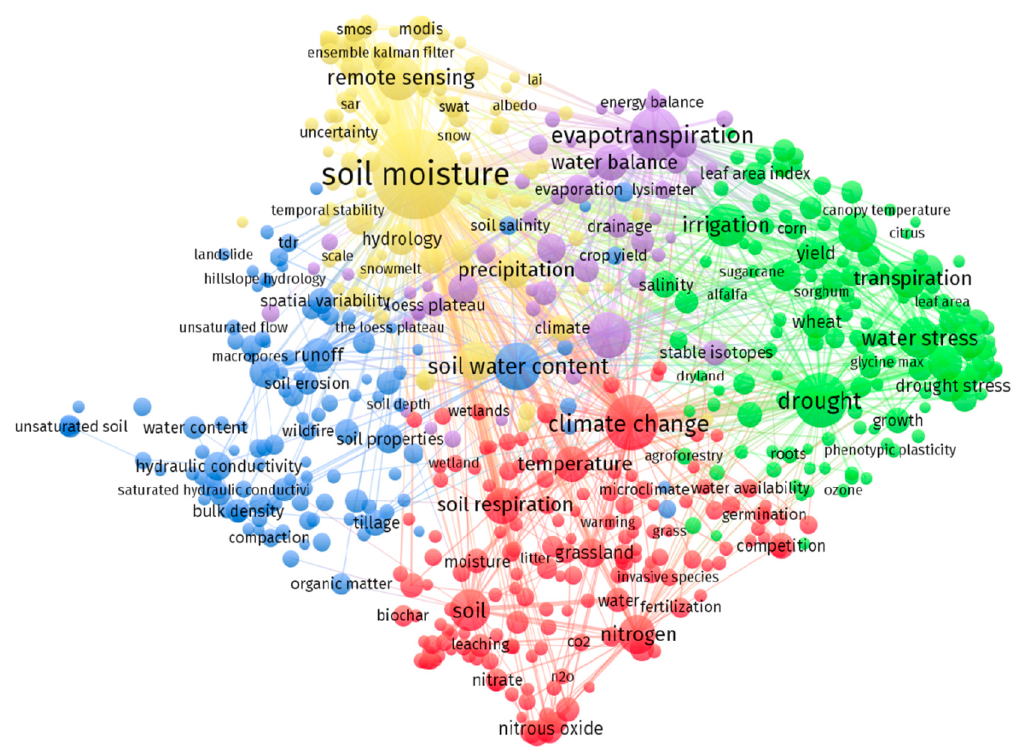
Figure 6. The co-occurrence network map of keywords published more than 50 times from 1990 to